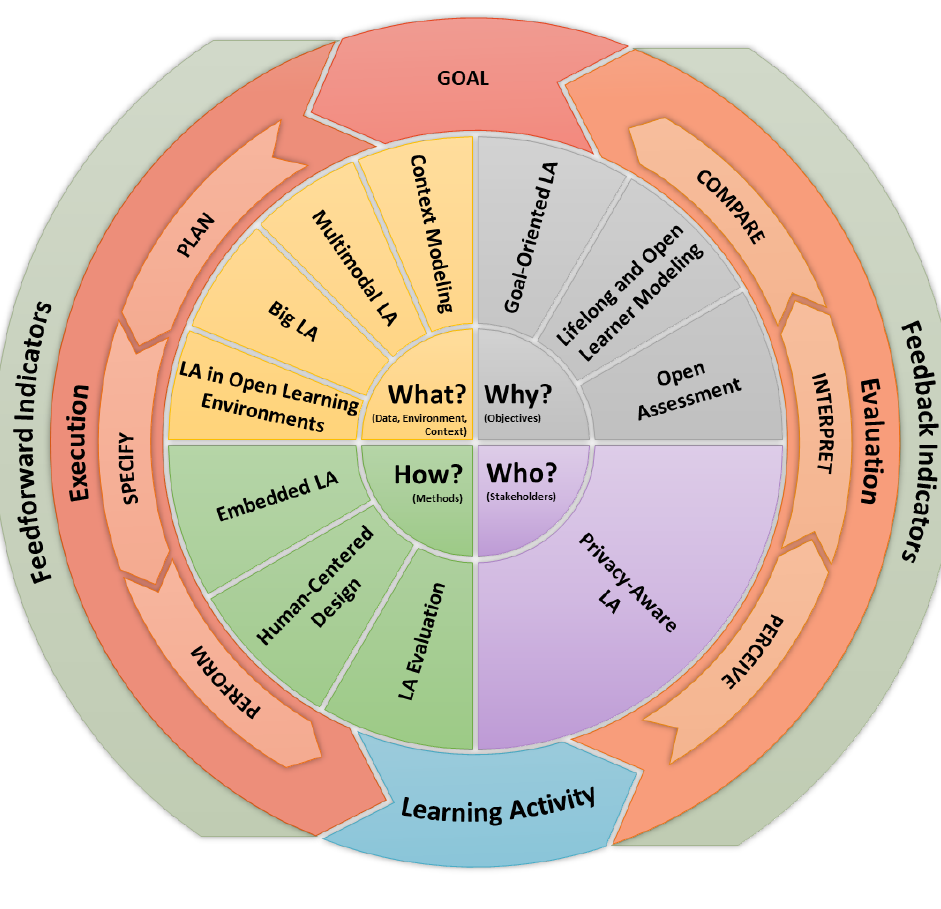
Figure 2. The PERLA